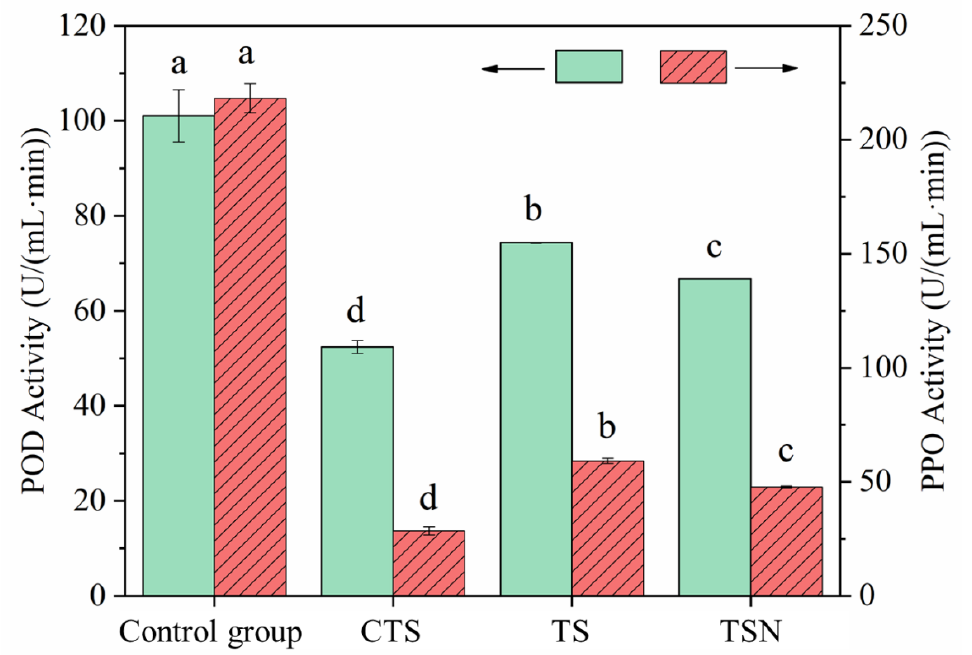
Figure 3. Passivation effects of different sterilization treatments on the enzyme activity of grape juice.